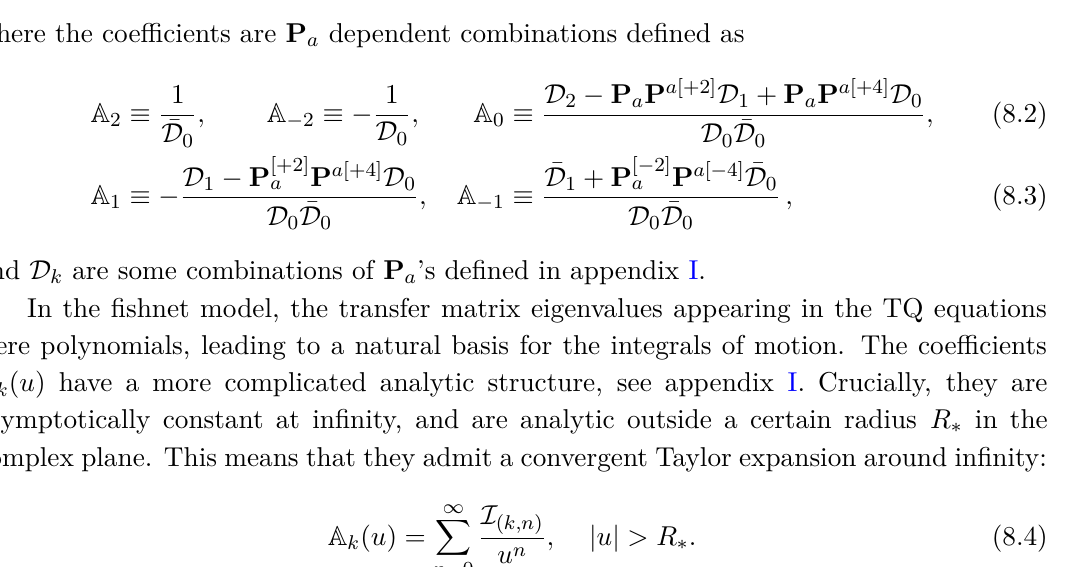
Figure 5 . Analytic structure of P and Q functions. In the fishnet limit g → 0 and the cuts collapse into